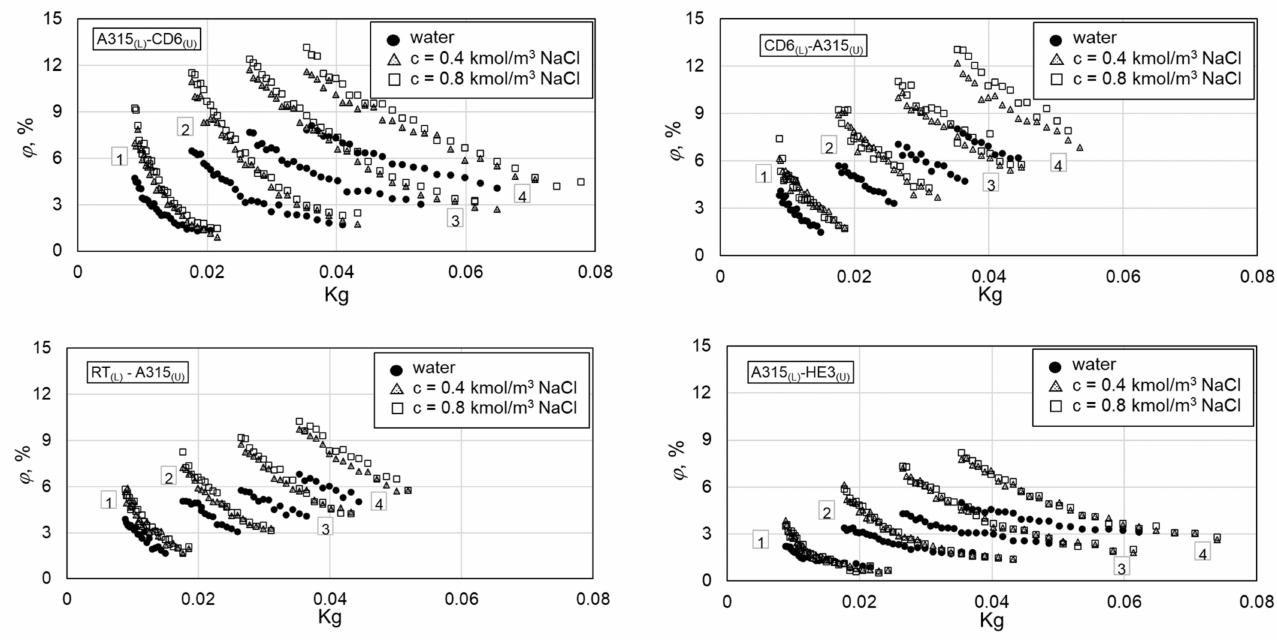
Figure 8. The distribution of gas hold-up as a function of a number of gas flow Kg for different superficial gas velocity w og : 1— w og = 1.706 × 10 − 3 m/s, 2— w og = 3.413 × 10 − 3 m/s, 3— w og = 5.119